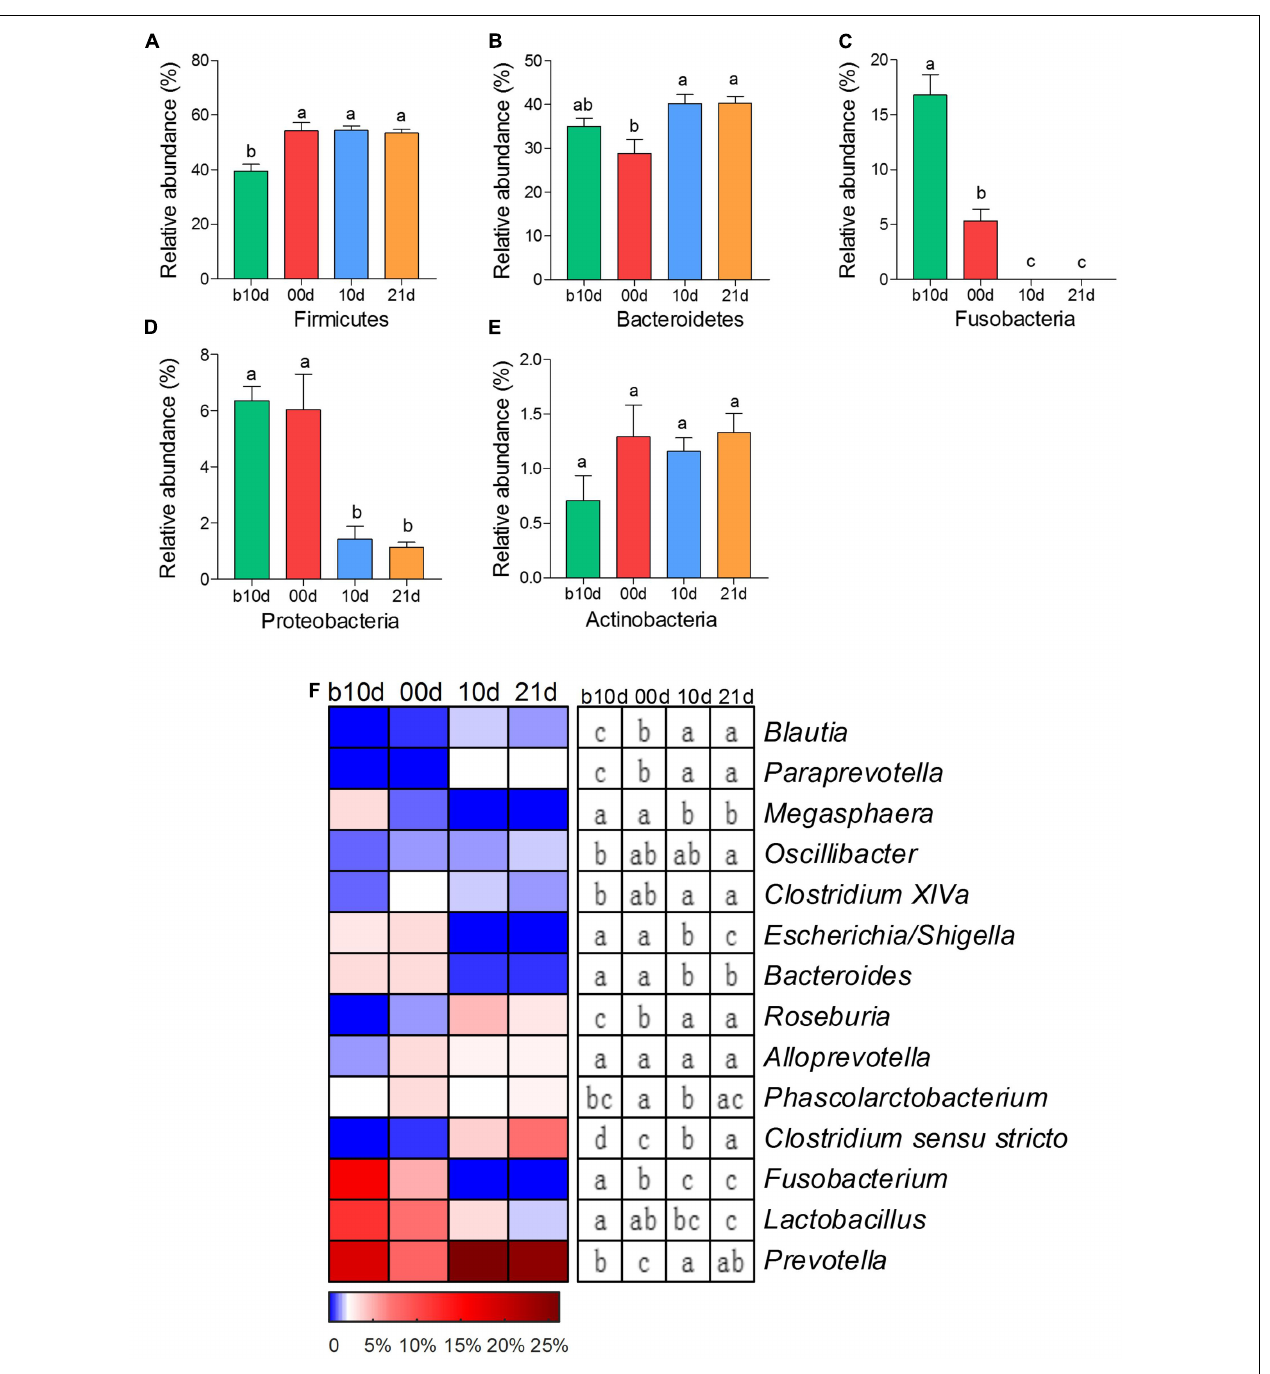
FIGURE 2 | The shifts of 5 predominant phyla and 14 predominant genera in the gut bacterial compositions of piglets during the weaning transition. (A) Firmicutes (B) Bacteroidetes (C) Fusobacteria (D) Proteobacteria (E) Actinobacteria. (F) The change in the relative abundance of predominant genera as piglets aged. The color of the spots in the panel represents the relative abundance of the predominant genera. Mean values ± SEM are shown. Different letters above the bar or in boxes denote significant difference between groups tested by paired sample Wilcoxon signed-rank test and adjusted by FDR.